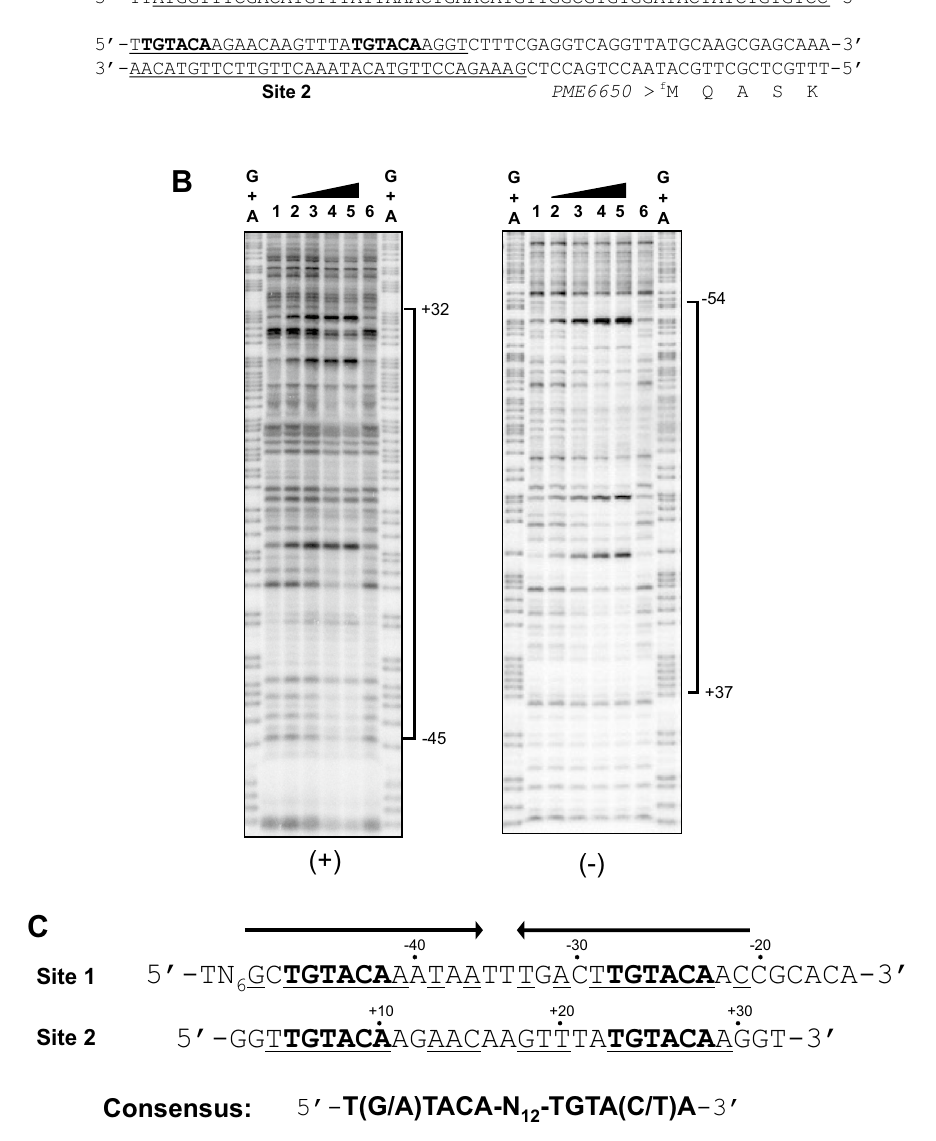
Figure 2. Determination of the PmlR2-binding sites by DNase I footprint analysis. ( A ) The nucleotide sequence of P 6650 . PmlR2-binding sites are underlined. The consensus (5 ′ -T(G/A)TACA and TGT ACA ) for P. putida PplR1-binding is denoted by bold letters including Site 1 and Site 2. The transcriptional start site of P 6650 , as determined by 5 ′ -RACE and CAGE, is indicated by + 1 and a vent arrow. Putative − 10 and − 35 hexamer sequences are shown in small letters. ( B ) DNase I footprint assay. One PmlR2-binding site in the sense ( +) and antisense ( −) strands of P 6650 was protected. The amounts of recombinant PmlR2 used were 0 pmol (lane 1 and 6), 10 pmol (lane 2), 20 pmol (lane 3), 40 pmol (lane 4), and 80 pmol (lane 5), which were added to the reaction mixture with 10 kcpm 32 P-labeled DNA probes. Three independent experiments in technical replicates were performed, and representative data were shown. The original and unprocessed versions of the full-length gels were included in Figs. S10 and S11. ( C ) The alignment of the two PmlR2-binding-sites with the P. putida PplR1